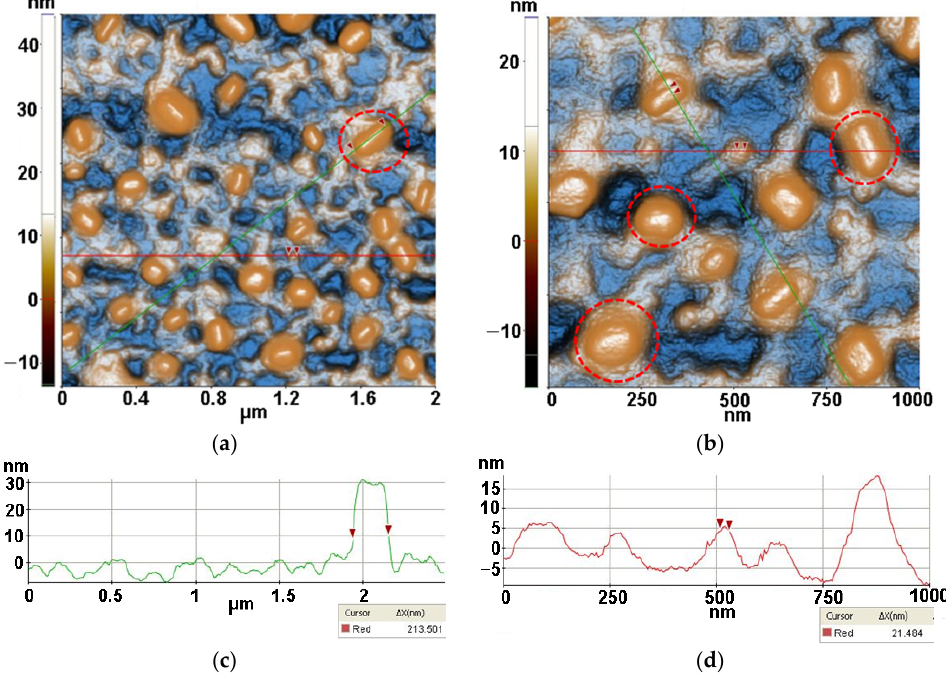
Figure 6. Two-dimensional AFM images for MC (from buffered suspension) deposited on Lys/TiO 2 /Si substrate, recorded at the scale of (2 μ m × 2 μ m) ( a ) and at the scale of (1 μ m × 1 μ m) ( b ), together with horizontal characteristic surface profiles (line-scans) collected from ( a ) green line ( c ), and from ( b ) red line ( d ).